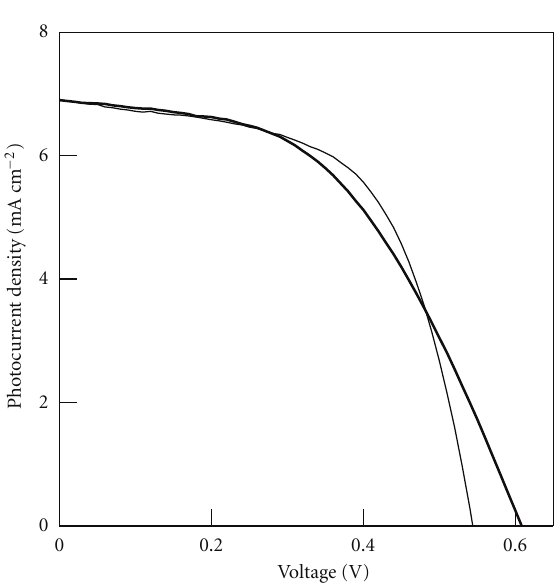
Figure 6: I-V curves of DSCs: monolithic structure with carbon electrode (thick line); sandwich structure with Pt/FTO electrode (thin line). Dye (Z907), nanocrystalline-TiO 2 electrodes, photoan- ode FTO, and ionic liquid electrolyte were the same in the two types of electrodes.